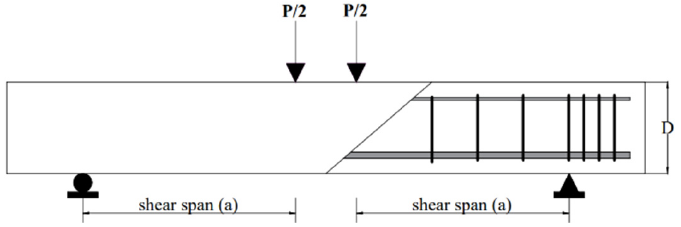
Figure 1. Loading pattern of the ECC beams.